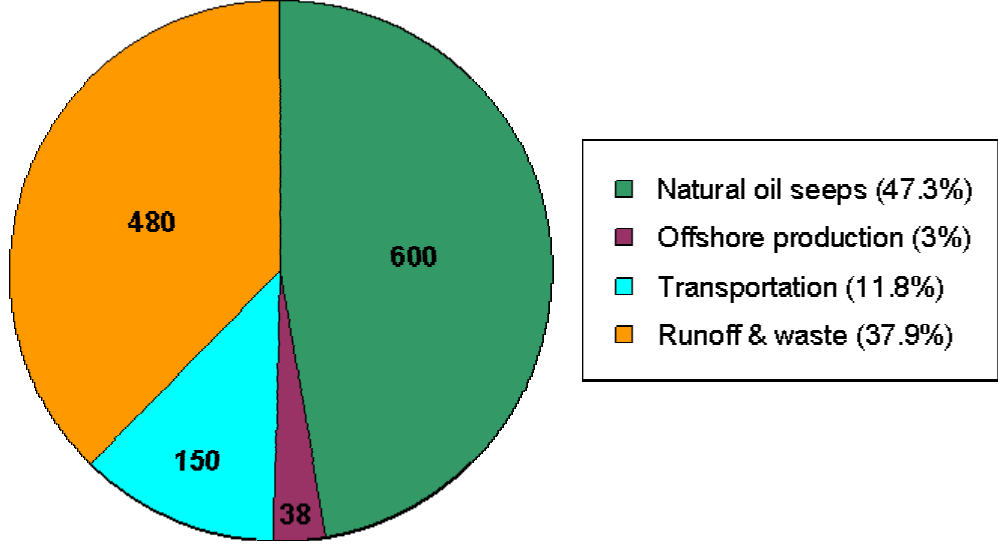
Figure 1. Sources of oil input into the oceans (in thousands of tons)